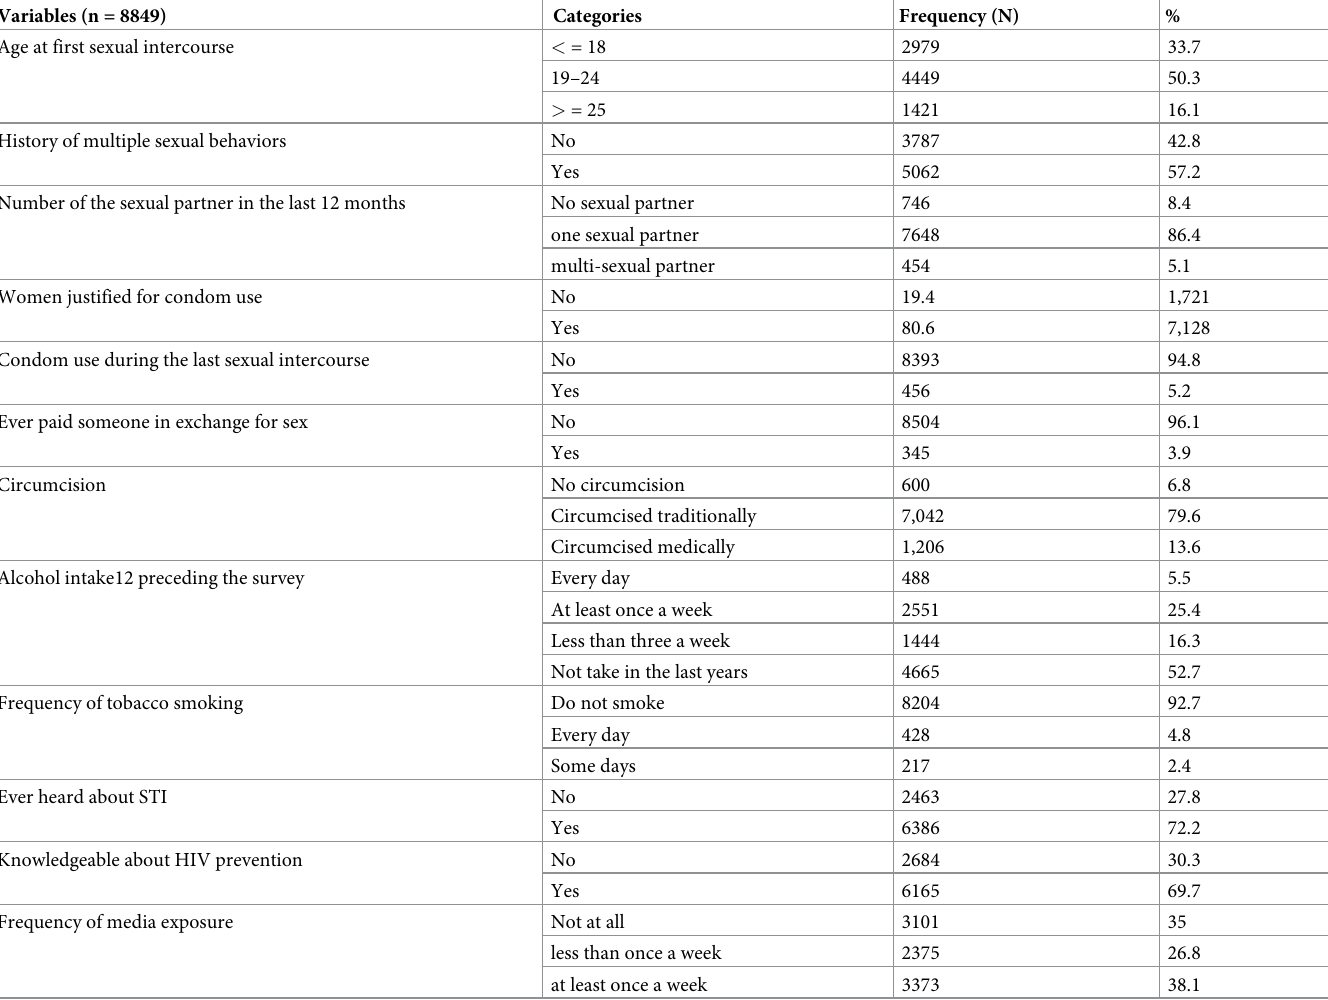
Table 2. Sexual behavior and practice, and STI related information among sexually active men in Ethiopia, 2016 EDHS. Variables (n =